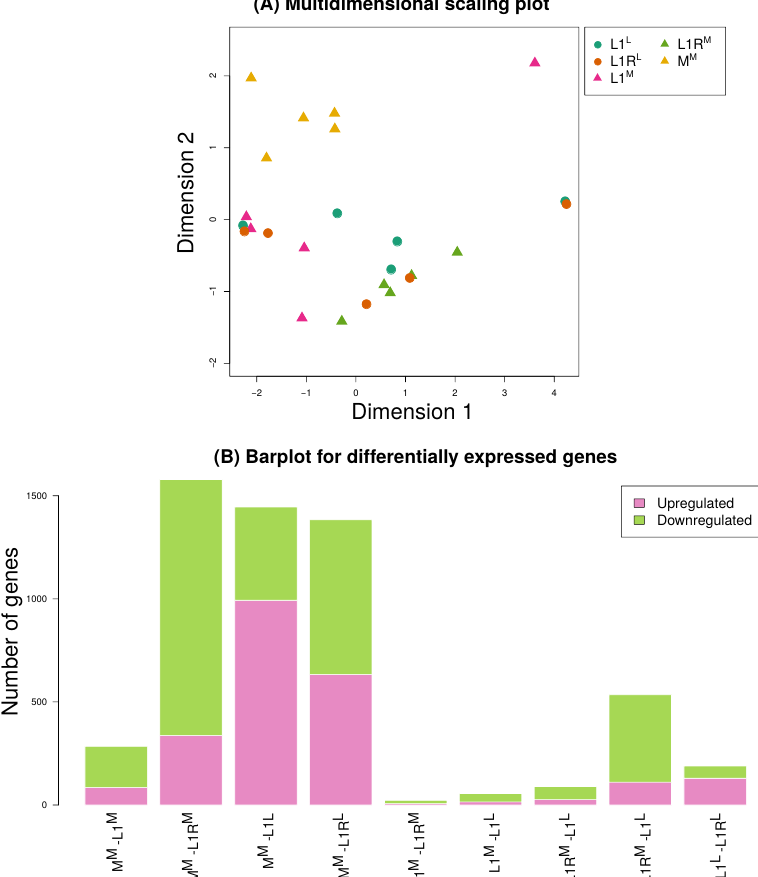
Figure 5. Summary of gene expression results. Panel ( A ) shows a NMDS ordination of the samples based on transformed count data. Points are labeled by line and host treatment. Bar plots in panel ( B ) depict the number of differentially expressed genes for each comparison, with colored regions denoting the number of upregulated versus downregulated genes in each contrast. Here, upregulated means that expression was higher in the first sample listed than in the second, and vice a versa for